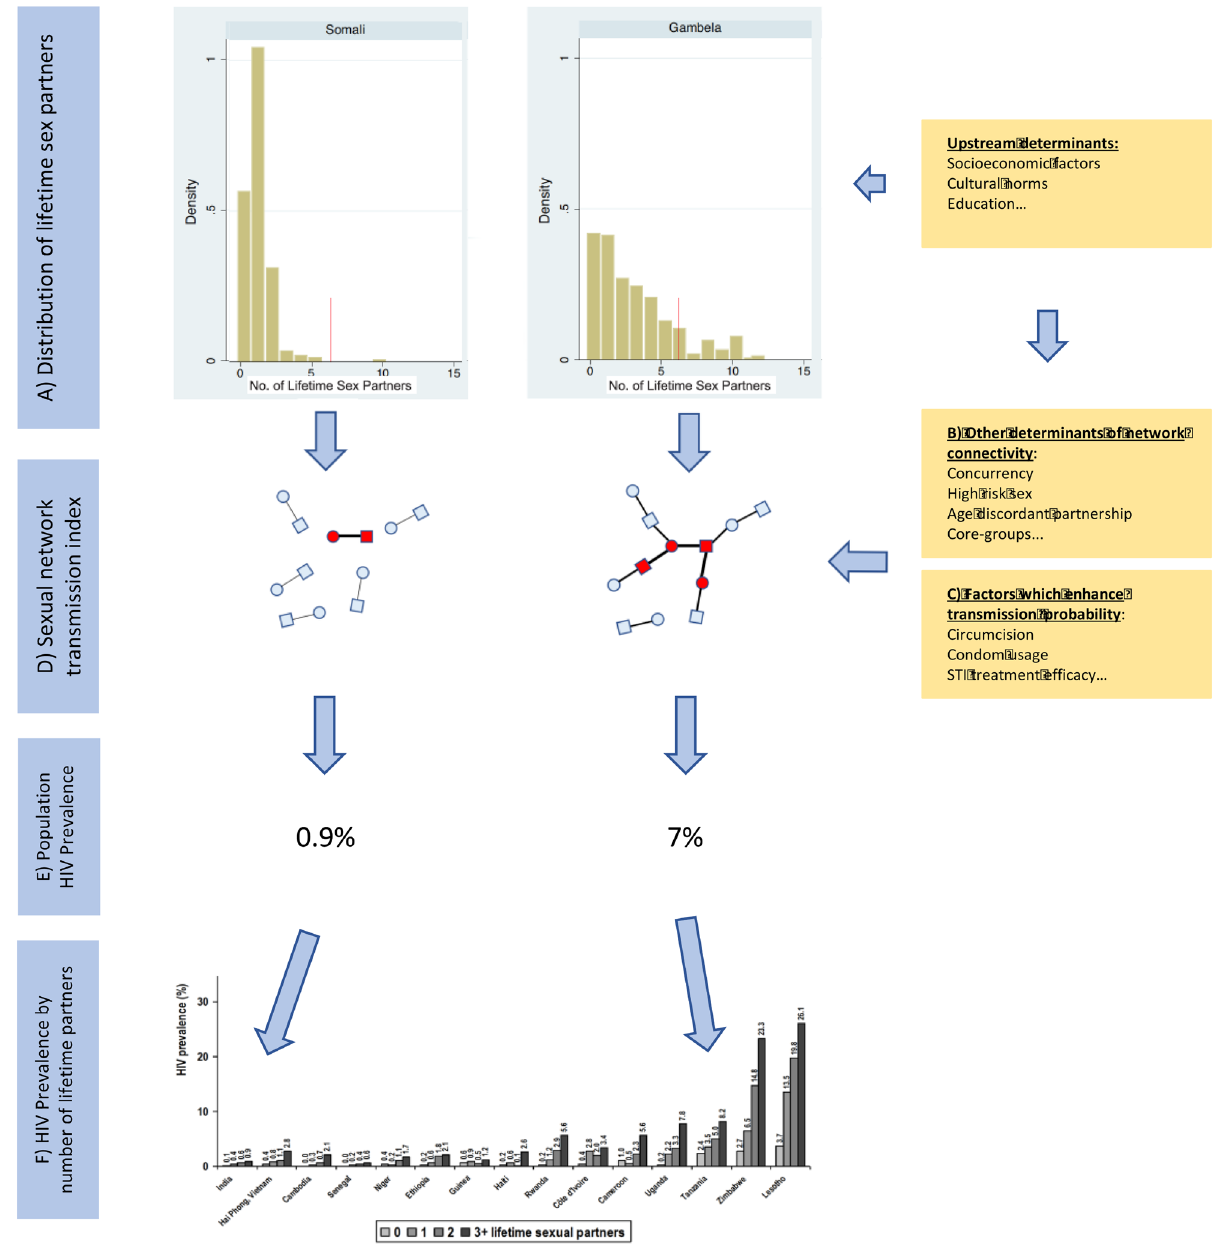
Figure 6. Conceptual framework for understanding how risk factors could come together to produce sexual networks that are higher risk for HIV transmission in certain populations than others, using the example of Ethiopian regions. ( A ) Men in Gambela (HIV prevalence 7%) report a higher number of lifetime sex partners (both median and percent with more than 6 partners – vertical red line) than those in the Somali region (HIV prevalence 0.9%) (Reproduced from [14] with permission). ( B ) This in conjunction with other determinants of enhanced network connectivity will result in a larger reachable path for HIV in Gambela than Somali. The reachable path is represented by the edges between nodes in the sexual networks. ( C ) The prevalence of other risk factors such as condom usage and circumcision influence the probability of HIV transmission per sexual contact (probability of transmission is depicted as proportional to edge width between nodes). ( D ) The composite of A, B and C determine the sexual network transmission index, which combines the reachable path determined by A and B with the probability of transmission ( C ) and results in a higher HIV prevalence (red nodes) in Gambela than Somali ( E ). Within both Gambela and Somali there is a stepwise increase in HIV prevalence with increasing number of partners, but given the higher sexual network transmission index in Gambela, the probability of HIV is higher for someone with a low number of partners in Gambela than someone with a high number of partners in Somali. ( F ) represents the HIV prevalence by number of lifetime sex partners for men 15–49 years from all DHS countries with available data. Graphic reproduced from [20] with permission. Somali most closely approximates India and Gambela, Tanzania.